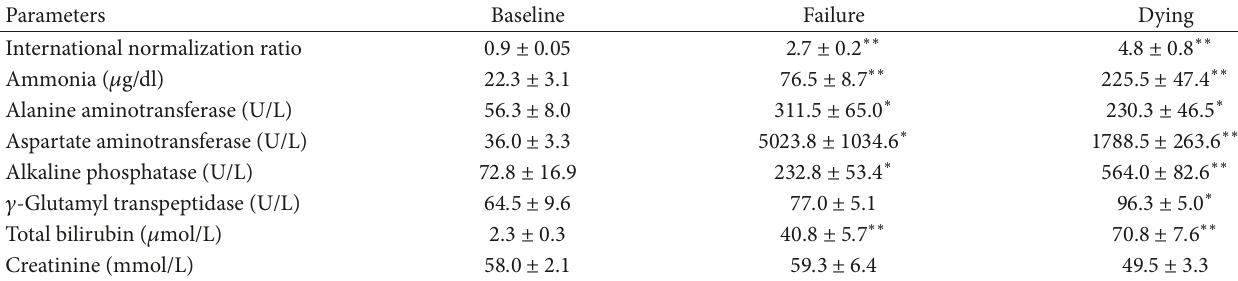
Table 1: Biochemical parameters in a porcine model of ALF.